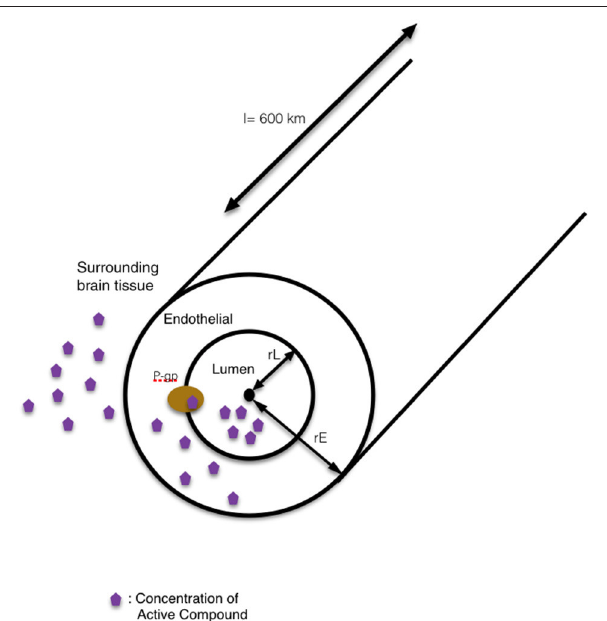
When free delphinidin is encapsulated into a